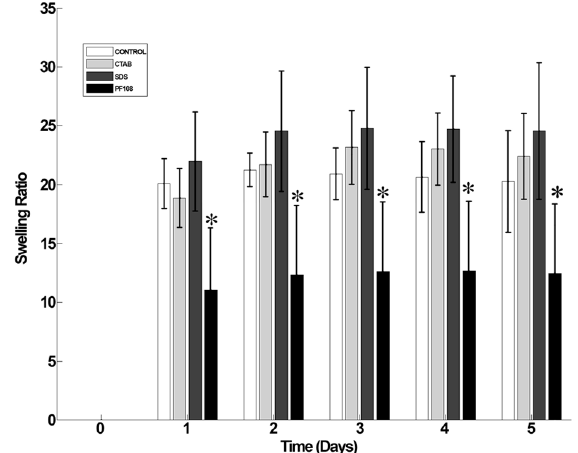
Figure 6. Swelling analysis of different surfactant/SWCNT-based hydrogels. * indicates statistically significant difference ( p < 0.05) in comparison with controls.